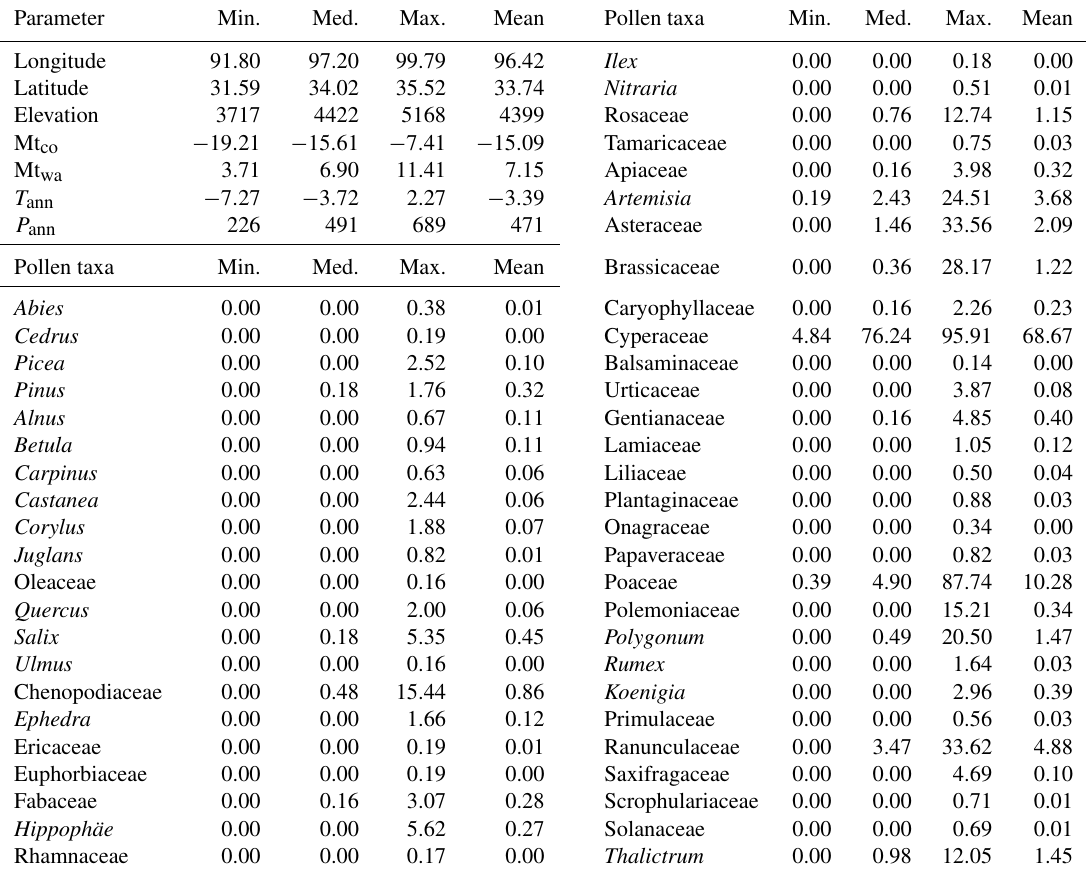
Table 1. Summary statistics for parameters in the pollen dataset. Min.: minimum; Med.: median; and Max.: maximum. Units for longitude and latitude are degrees, elevation is in metres above sea level, Mt co , Mt wa , and T ann are ◦ C, P ann is in millimetres, and pollen data are